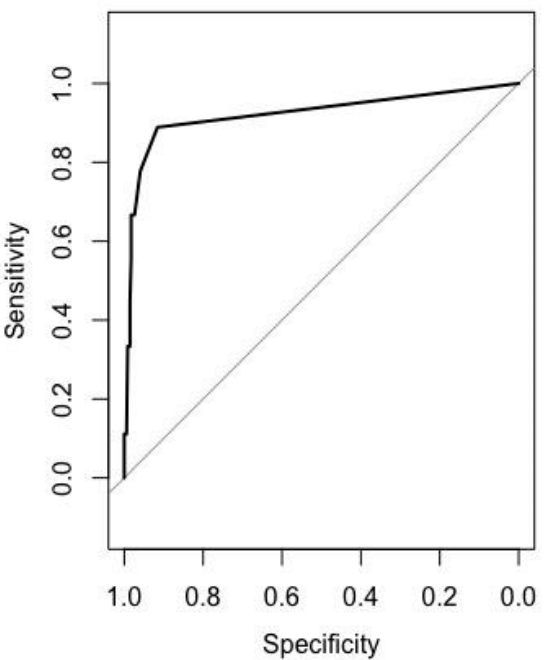
Figure 1. ROC curve of the H. pylori IgG to detect H. pylori infection.